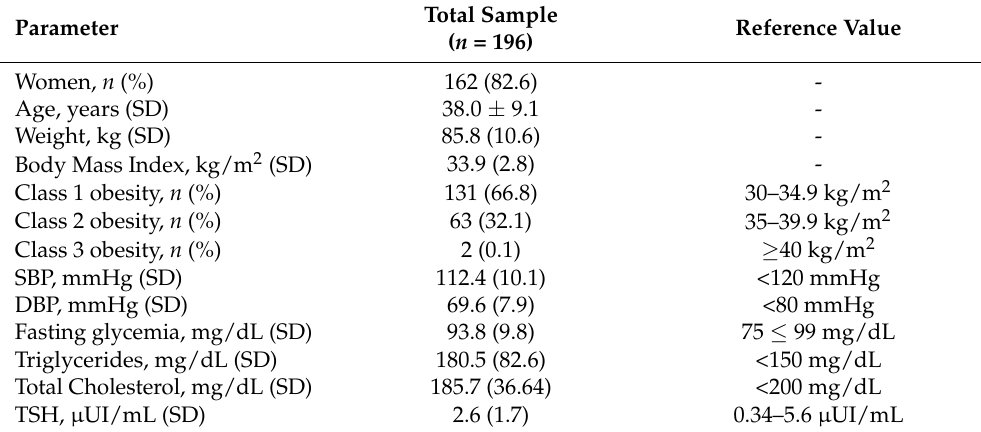
Table 1. Baseline characteristics of subjects in this study.